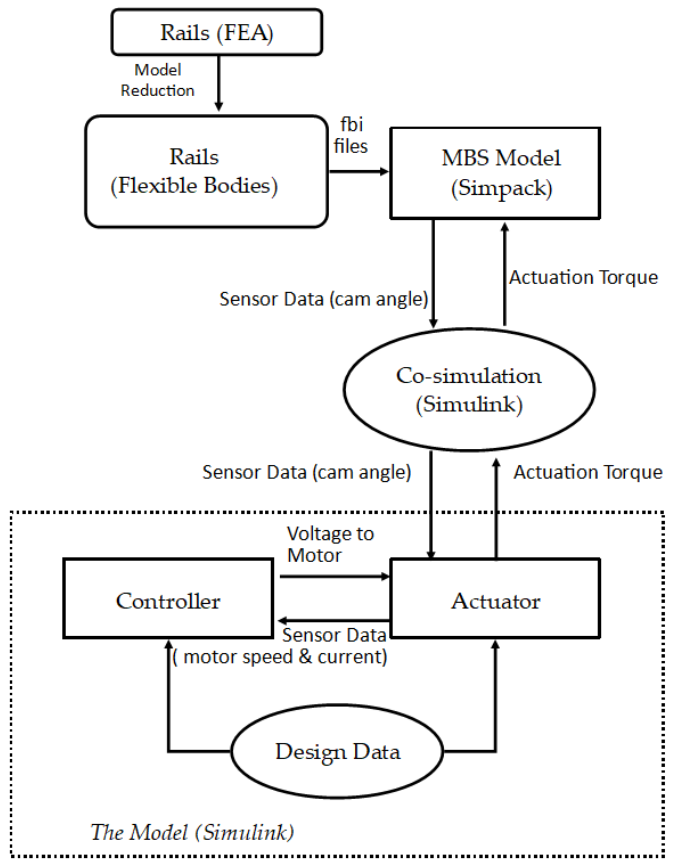
Figure 4. Modelling approach.